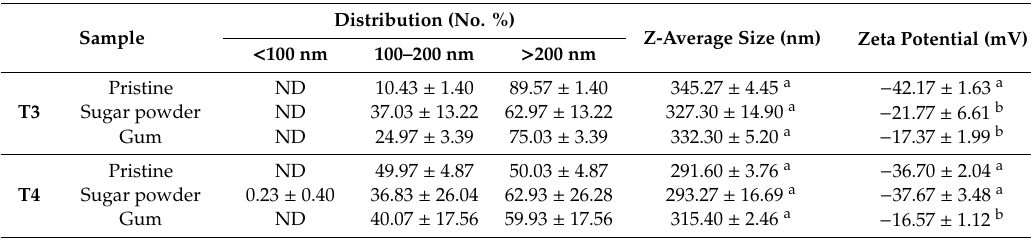
Figure 2. Scanning electron microscopy (SEM) images and size distributions of food additive TiO 2 (T3 and T4) recovered from simulated foods. Size distributions were obtained by randomly selecting 100 particles from SEM images. Table 3. Size distributions, hydrodynamic radii, and zeta potentials of food additive TiO 2 (T3 and T4) recovered from simulated foods.